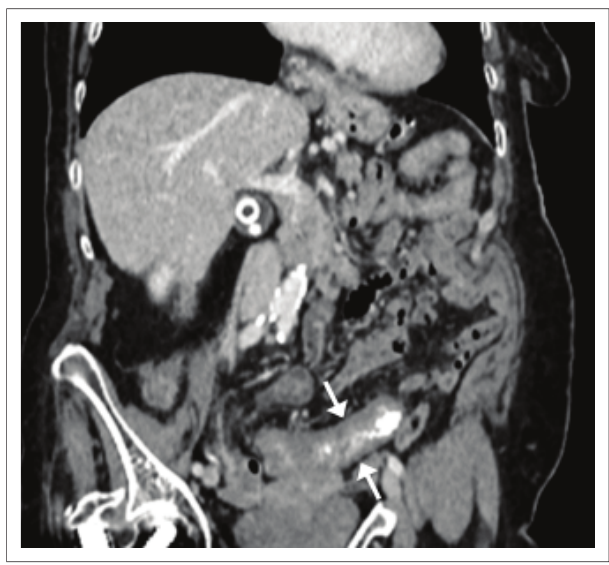
CT, computed tomography. FIGURE 4: Coronal reconstruction of portovenous phase–enhanced CT, of the above patient, again demonstrating circumferential mural thickening of the sigmoid colon.